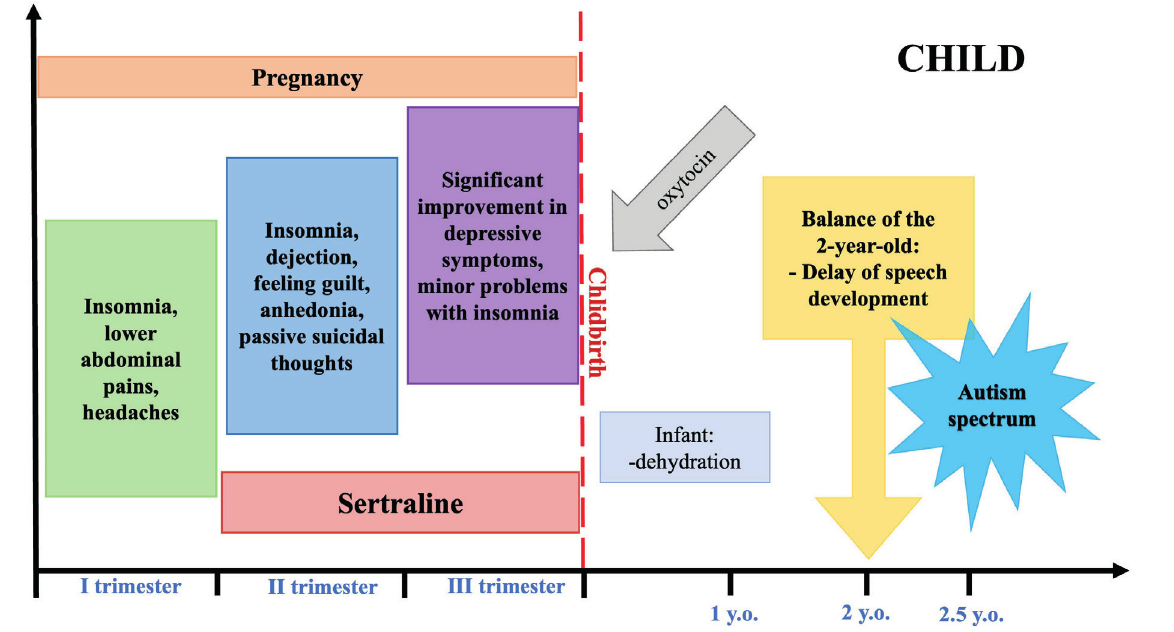
Fig. 1. Depressive symptoms in pregnancy, probable factors influencing the development of autism spectrum disorders in a